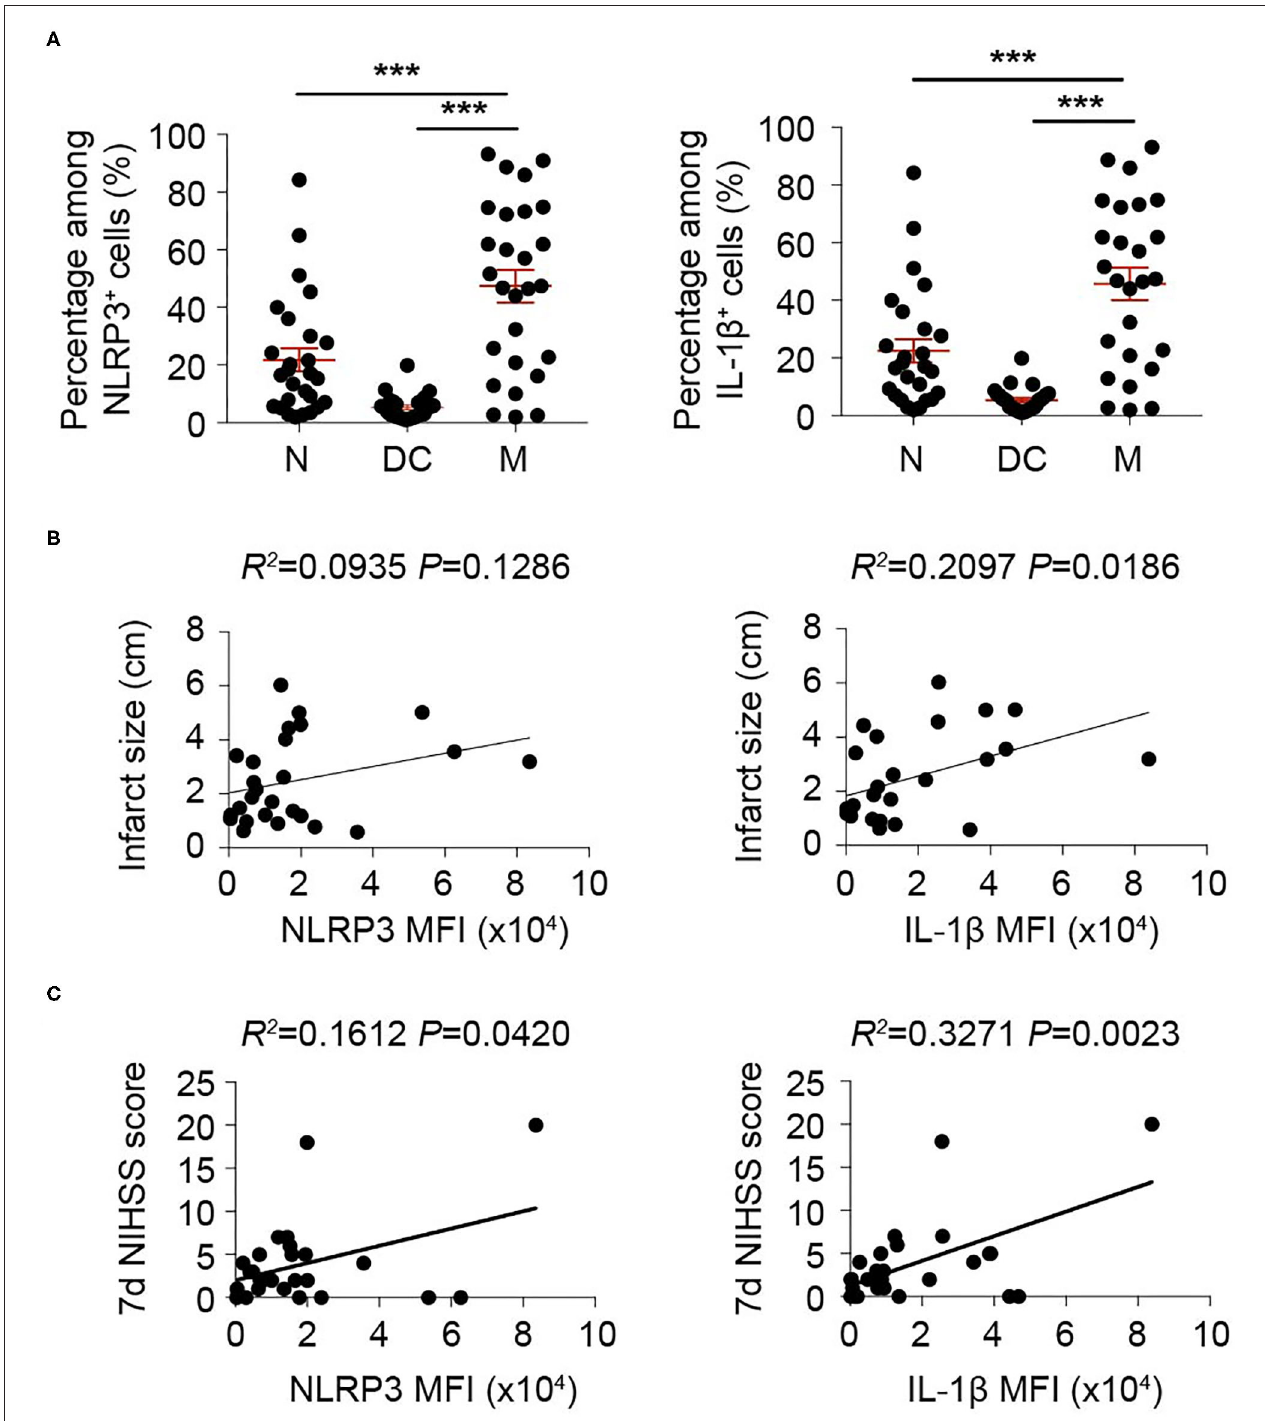
FIGURE 3 | Inflammasome activation in monocyte/macrophage is correlated with adverse stroke severity. Peripheral blood from 26 patients with acute ischemic stroke was collected within 24h of disease onset and analyzed with flow cytometry. (A) Cells that expressed NLRP3 and IL-1 β were gated in flow cytometric analysis (FACS). Percentage in NLRP3 + or IL-1 β + cells of neutrophil (N, CD45 + CD11b + CD66b + ), dendritic cells (DC, CD45 + CD11c + ) and monocyte/macrophage (M, CD45 + CD11b + CD14 + ) were assessed. *** P < 0.001 in One-way ANOVA . (B,C) Mean fluorescent intensity (MFI) of NLRP3 or IL-1 β in monocyte/macrophage (CD45 + CD11b + CD14 + ) was calculated. Correlation of NLRP3 MFI or IL-1 β MFI with infarct size (B) or NIHSS score assessed at 7 d (C) after disease onset was analyzed with Linear regression .